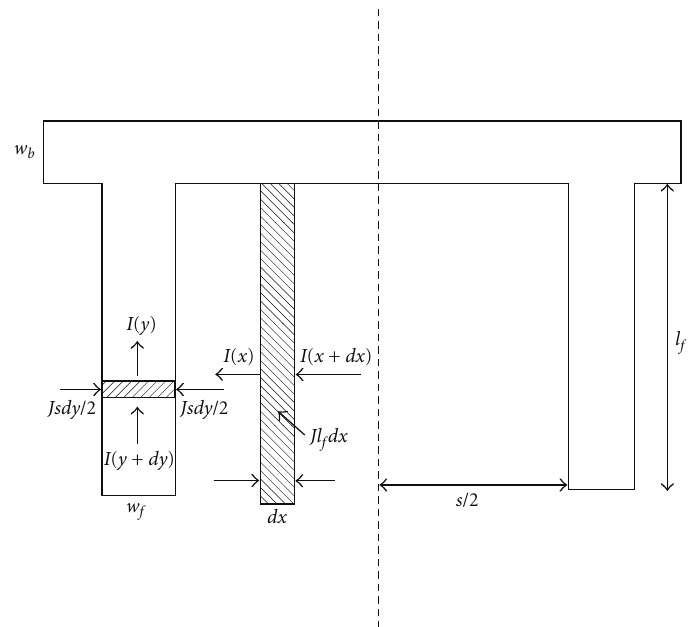
Figure 9: Section of the top region of the solar cell indicating the fingers, bus-bars, and the emitter